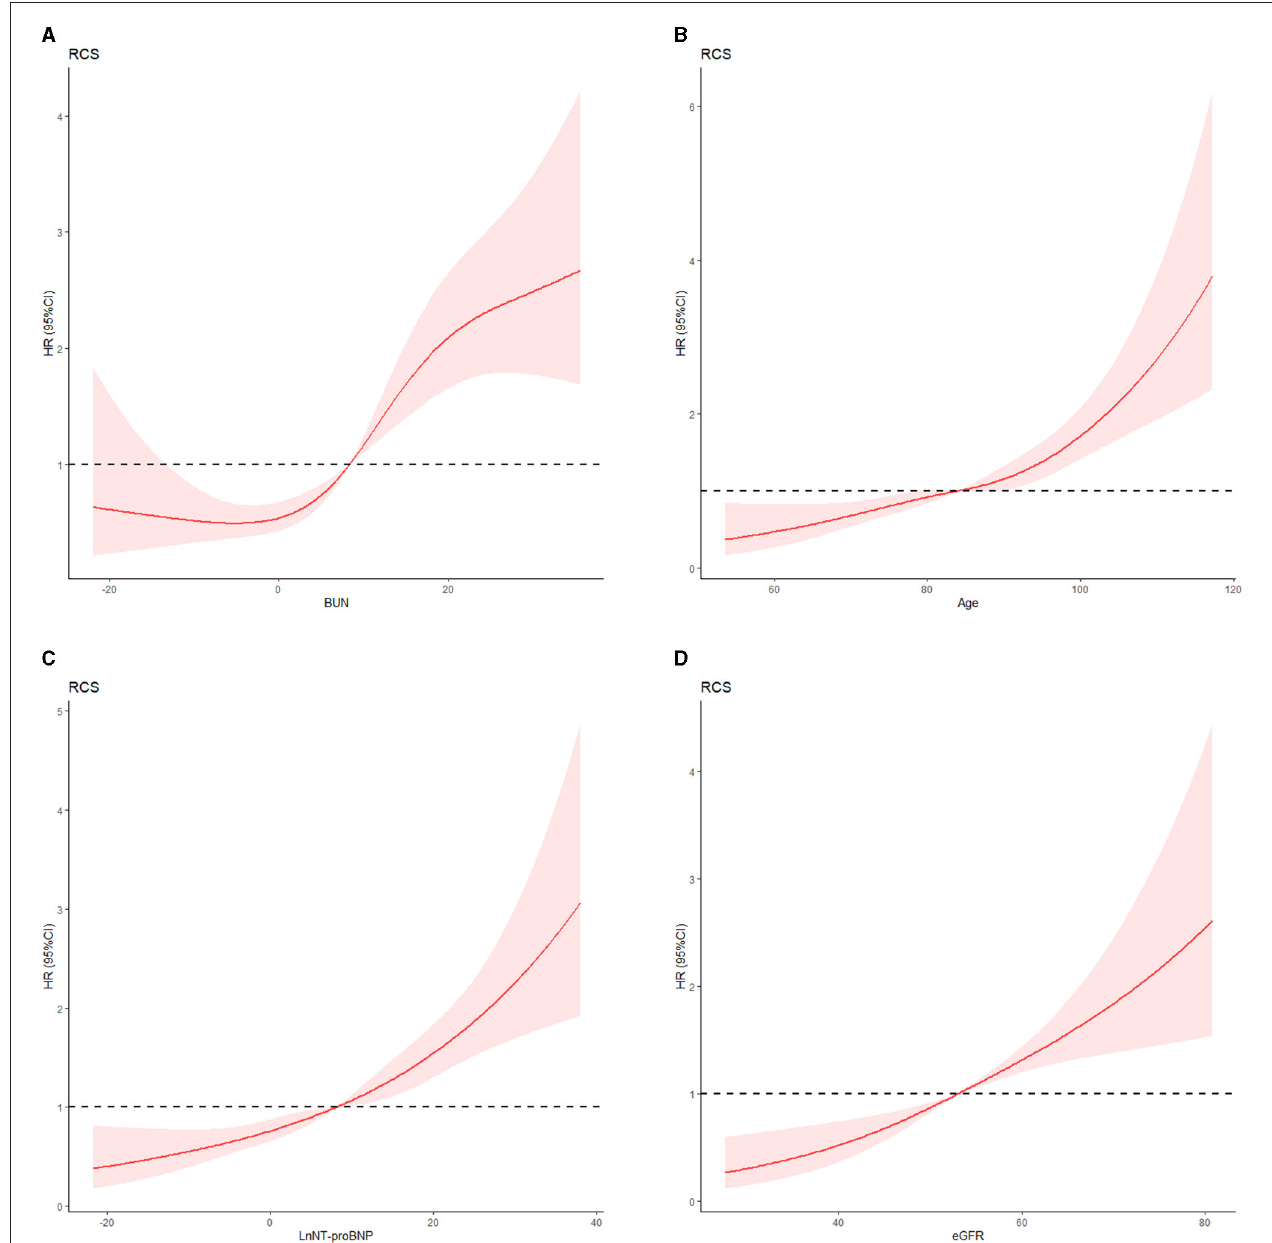
FIGURE 2 | (A) Blood urea nitrogen level and 180-day heart failure readmission risk. (B) Age and 180-day heart failure readmission risk. (C) Natural logarithm of plasma N-terminal pro-B-type natriuretic peptide (LnNT-proBNP) and 180-day heart failure readmission risk. (D) Estimated glomerular filtration rate and 180-day heart failure readmission risk. We used a three-level classification of BUN, eGFR, and LnNT-proBNP and five-level classification of age according to the results of restricted cubic spline and clinical meanings.